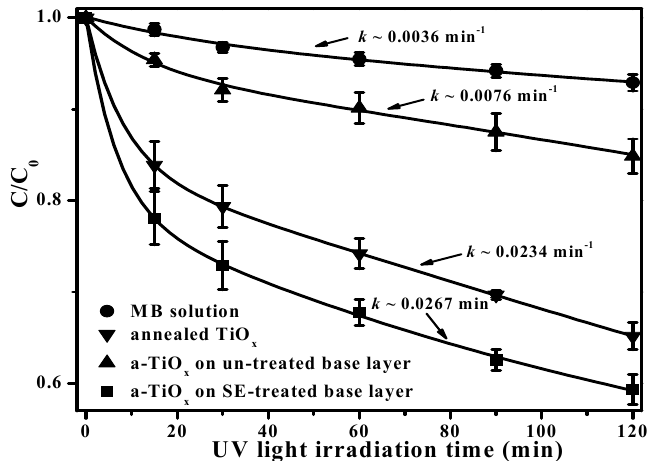
Figure 9. Photo-degradation to MB solution using a-TiO x films deposited onto untreated and SFE-treated base layers as well as using the annealed TiO x film (MB solution decomposed by the UV light irradiation also is shown for comparison).